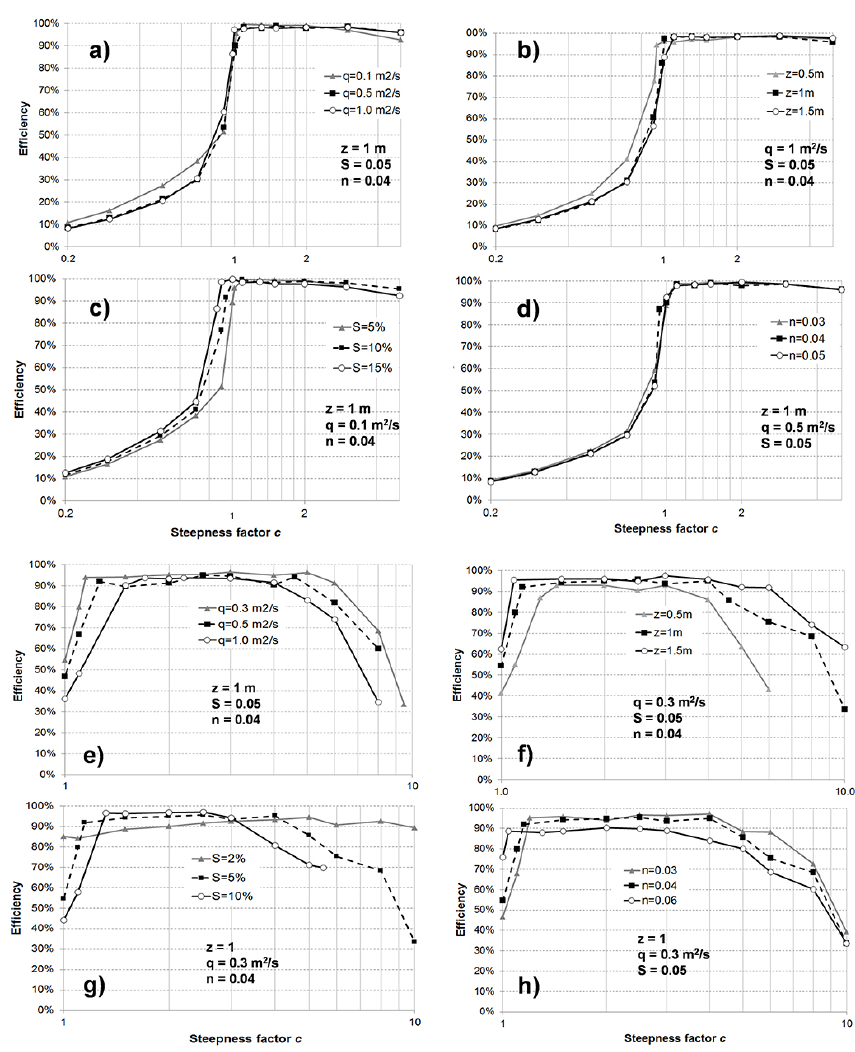
Fig. 6. Efficiency as a function of the steepness factor c for a range of conditions. n represents the Manning roughness coefficient; q the unitary discharge; S the bed slope; and z the effective check dam